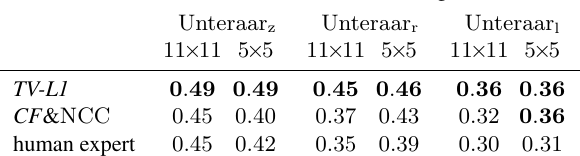
Figure 3: Depicted are patches in which the computed flow-fields differ Figure 2: Image similarity at corresponding points ac- grossly from the manual estimates. Errors occur if the true motion is not cording to TV-L1 and to manual flow estimates. NCC visible on the surface ( col. 1,2 ). Here the objective to match corresponding scores are overlain onto the images using color-code. image content can distort the flow fields ( col. 3,4 ). Flow vectors are color Areas in red mark higher similarity with TV-L1 , green coded with respect to their magnitude ( blue =slow flow, red =fast flow). areas higher scores of the manual measurements. Table 4: Mean NCC scores of different